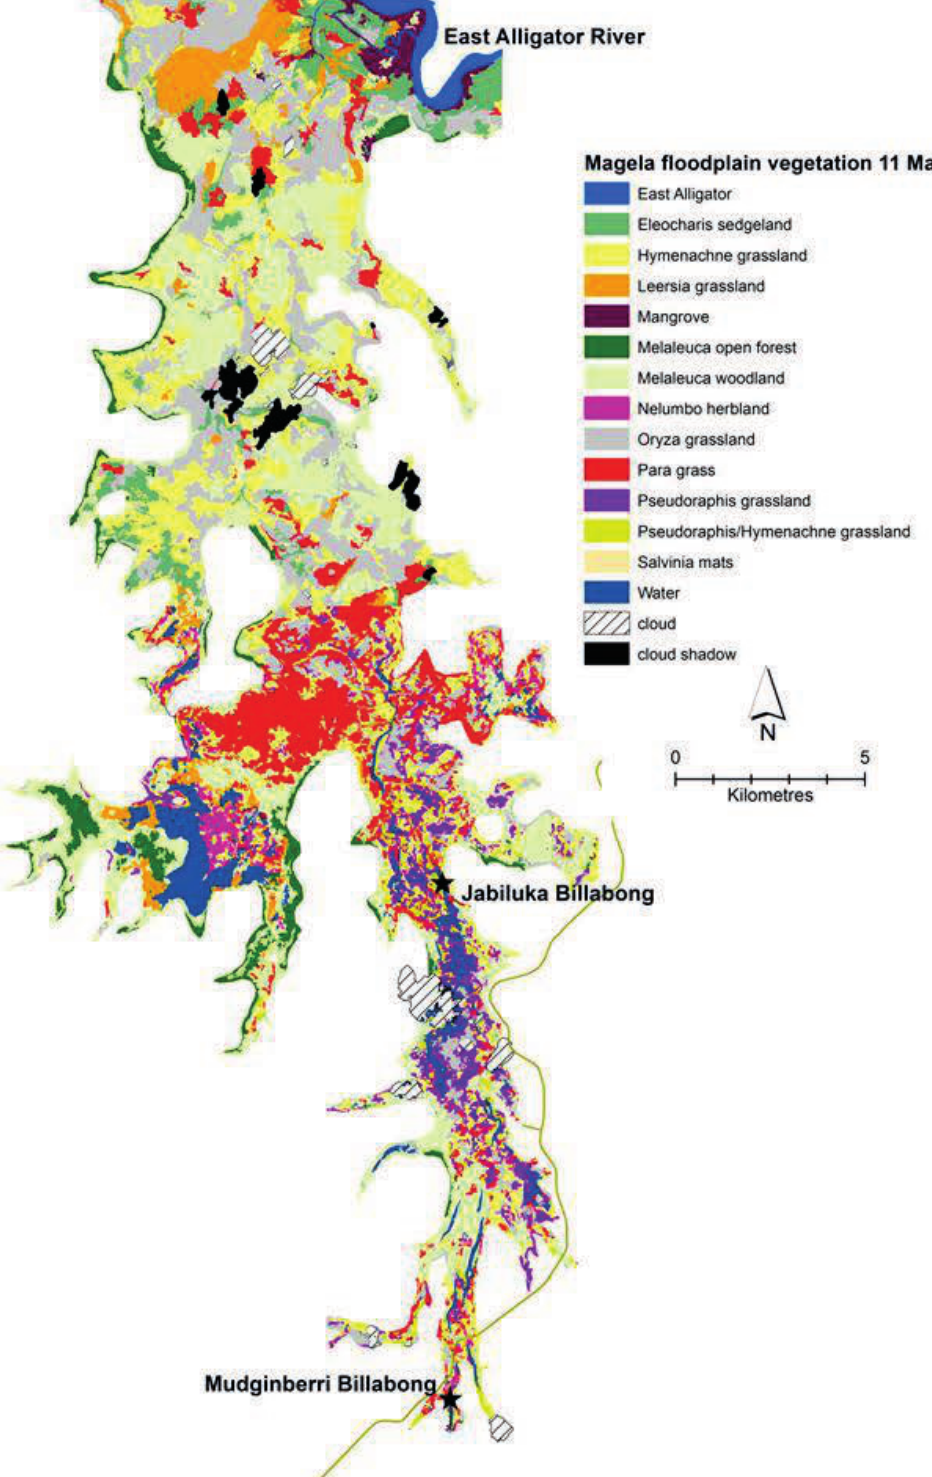
Fig. 2 Vegetation communities of lower Magela Creek